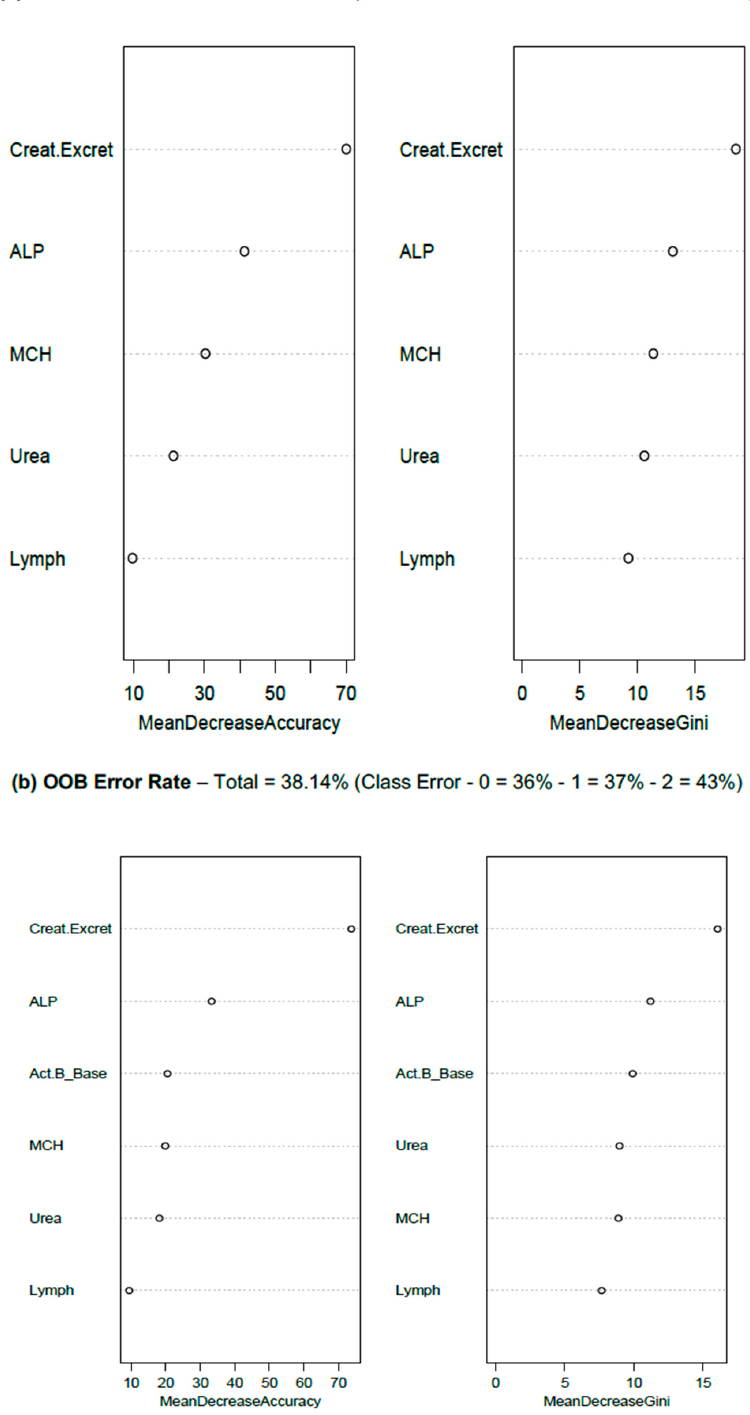
Figure 2. Random Forest plots of ( a ) a model using basic blood and urine test pathology markers to predict Weighted Standing Time (WST) classes (0, 1, 2) of ME/CFS, ( b ) the same model with Activin B results added. The left column represents the RFA Importance measure, and the right column the ranking of predictors by Gini Index. Refer to Table 1b for WST Class definitions. OOB—Out of Bag (Error Rate). Creat.Excret (24-h urinary creatinine excretion rate); ALP (serum alkaline phosphatase); Act.B_Base (first appointment, serum activin B assay); MCH (mean corpuscular haemoglobin); Urea (serum urea); Lymph (blood lymphocyte count).